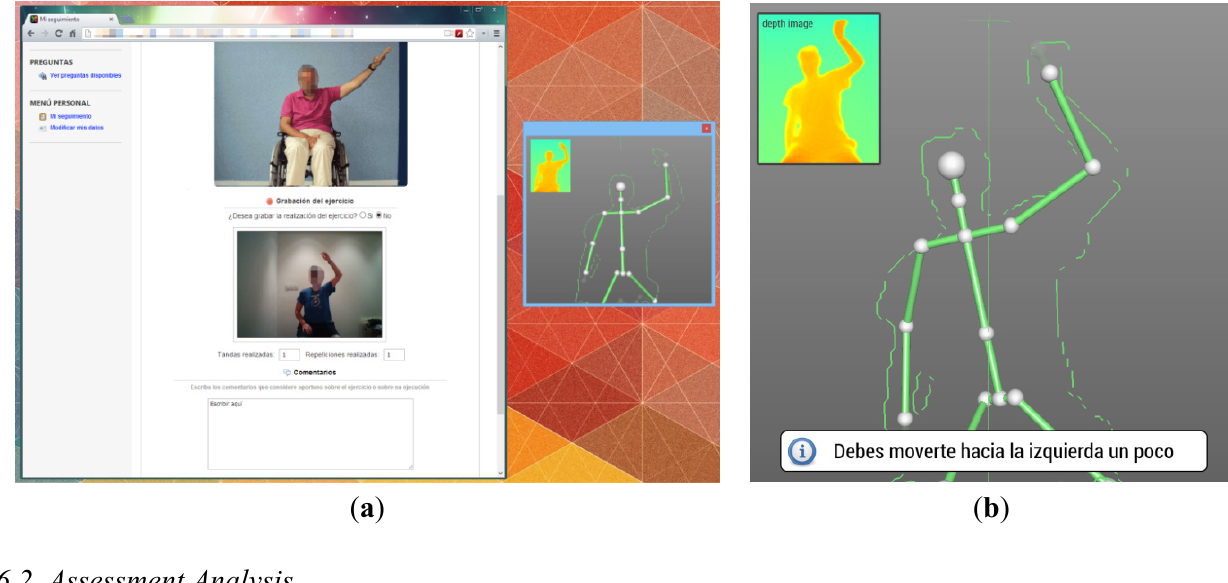
Figure 8. ( a ) Rehabilitation tool; ( b ) Warning